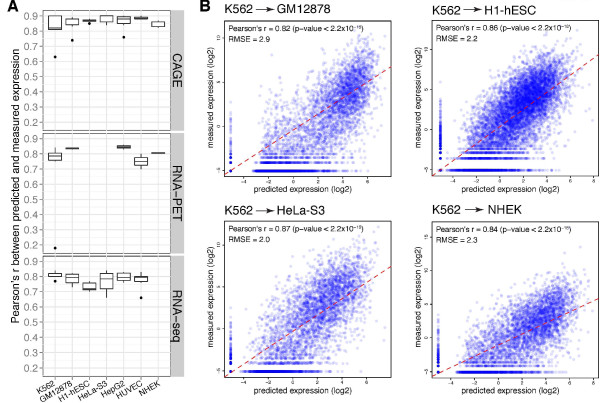
Comparison of prediction accuracy across different cell lines. (a) Boxplot of correlation coefficients for seven cell lines (K562, GM12878, H1-hESC, HeLa-S3, HepG2, HUVEC and NHEK) with different types of expression quantification (CAGE, RNA-PET, and RNA-Seq). It shows that the high quantitative relationship between chromatin features and expression exist in various cell lines and using different expression quantification methods. Paired Wilcoxon tests between H1-hESC and other cell lines show that H1-hESC has significantly lower prediction accuracy (P-value = 0.02, 0.02, 0.07, 0.02, and 0.05 for K562, GM12878, HeLa-S3, HepG2 and HUVEC, respectively). (b) Application of the model learned from K562 to other cell lines (GM12878, H1-hESC, HeLa-S3 and NHEK) indicates that the model performs well across cell lines (r = 0.82, 0.86, 0.87 and 0.84, respectively). This indicates that the quantitative relationship between chromatin features and gene expression is not cell line-specific, but rather a general feature.